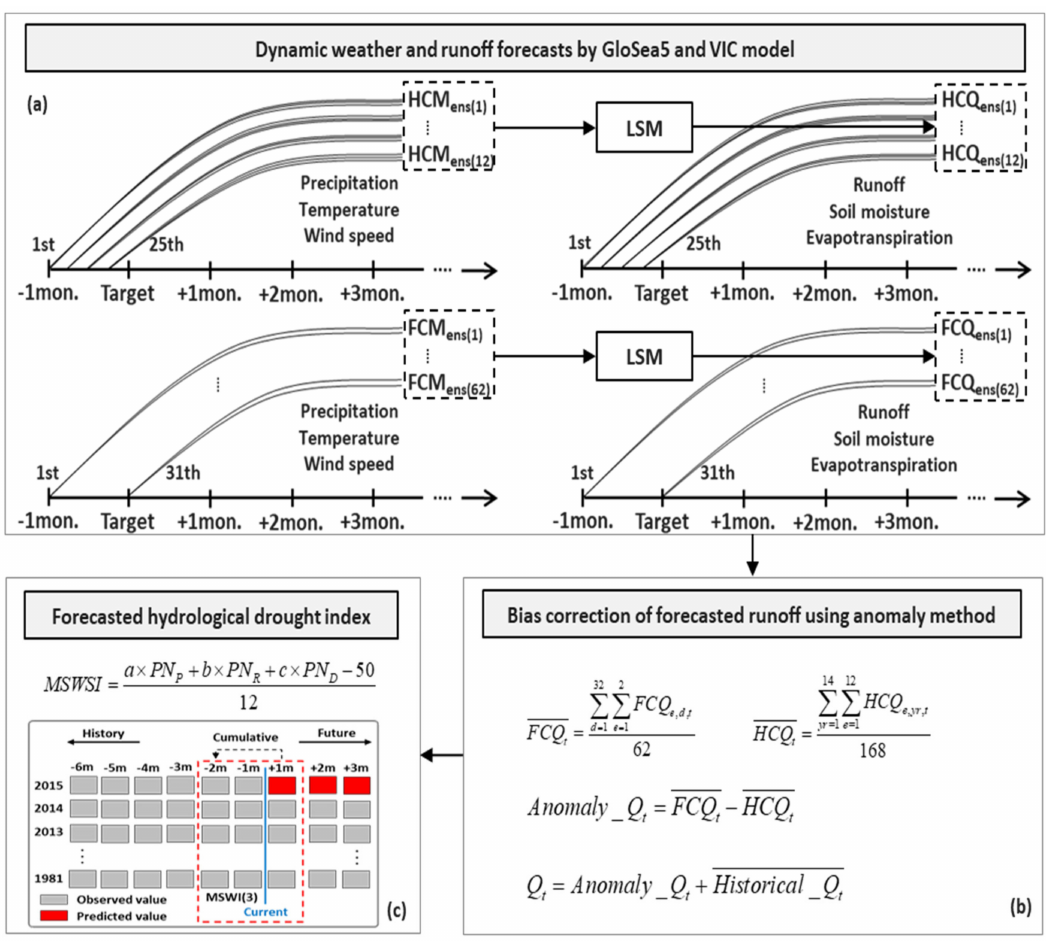
Figure 2. Outline of the hydrological drought forecasting framework. ( a ) procedure for the dynamic weather and runo ff forecasts by GloSea5 and VIC model; ( b ) procedure for the bias correction of forecasted runo ff using anomaly method; ( c ) procedure for the forecasted hydrological drought